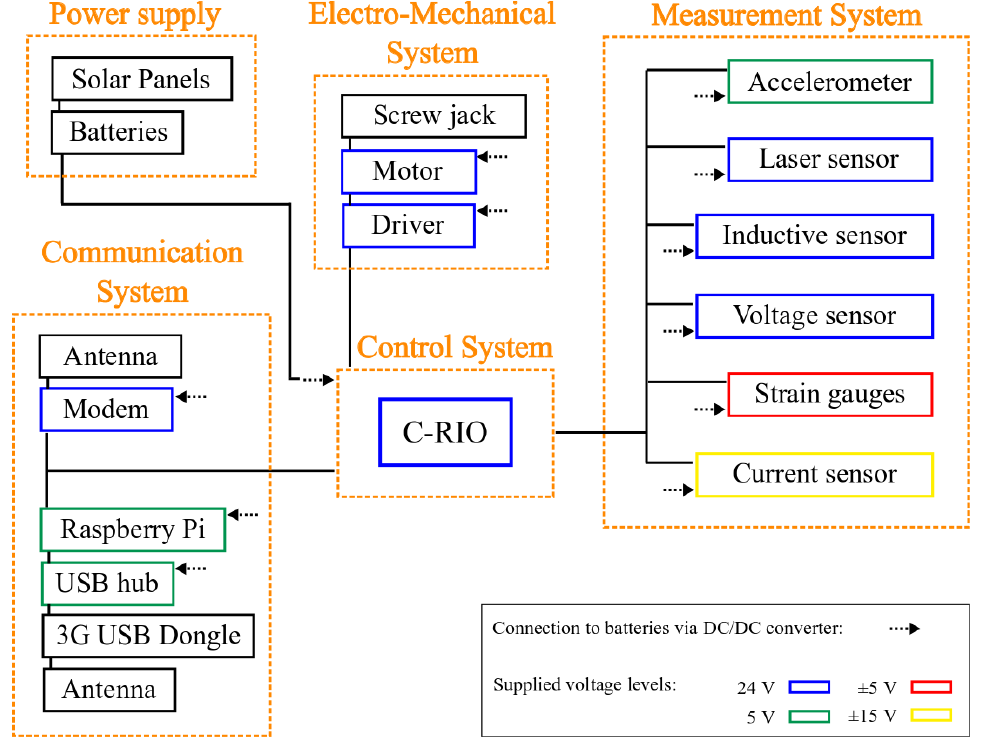
Figure 1. Schematic of the systems installed inside the